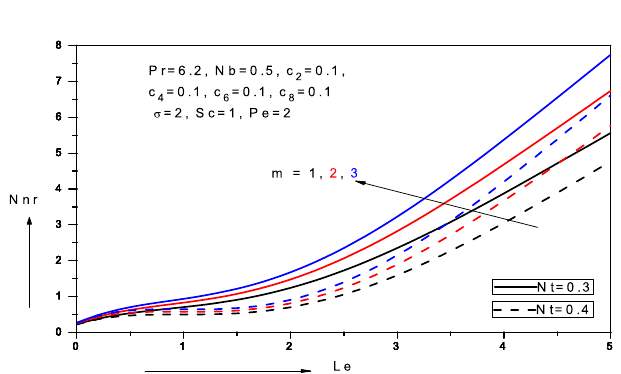
Figure 19. Variation of reduced density number of motile micro-organism ( Nnr ) with Lewis number ( Le ), thermophoresis parameter ( Nt ) and velocity power-law index ( m ) in water-based